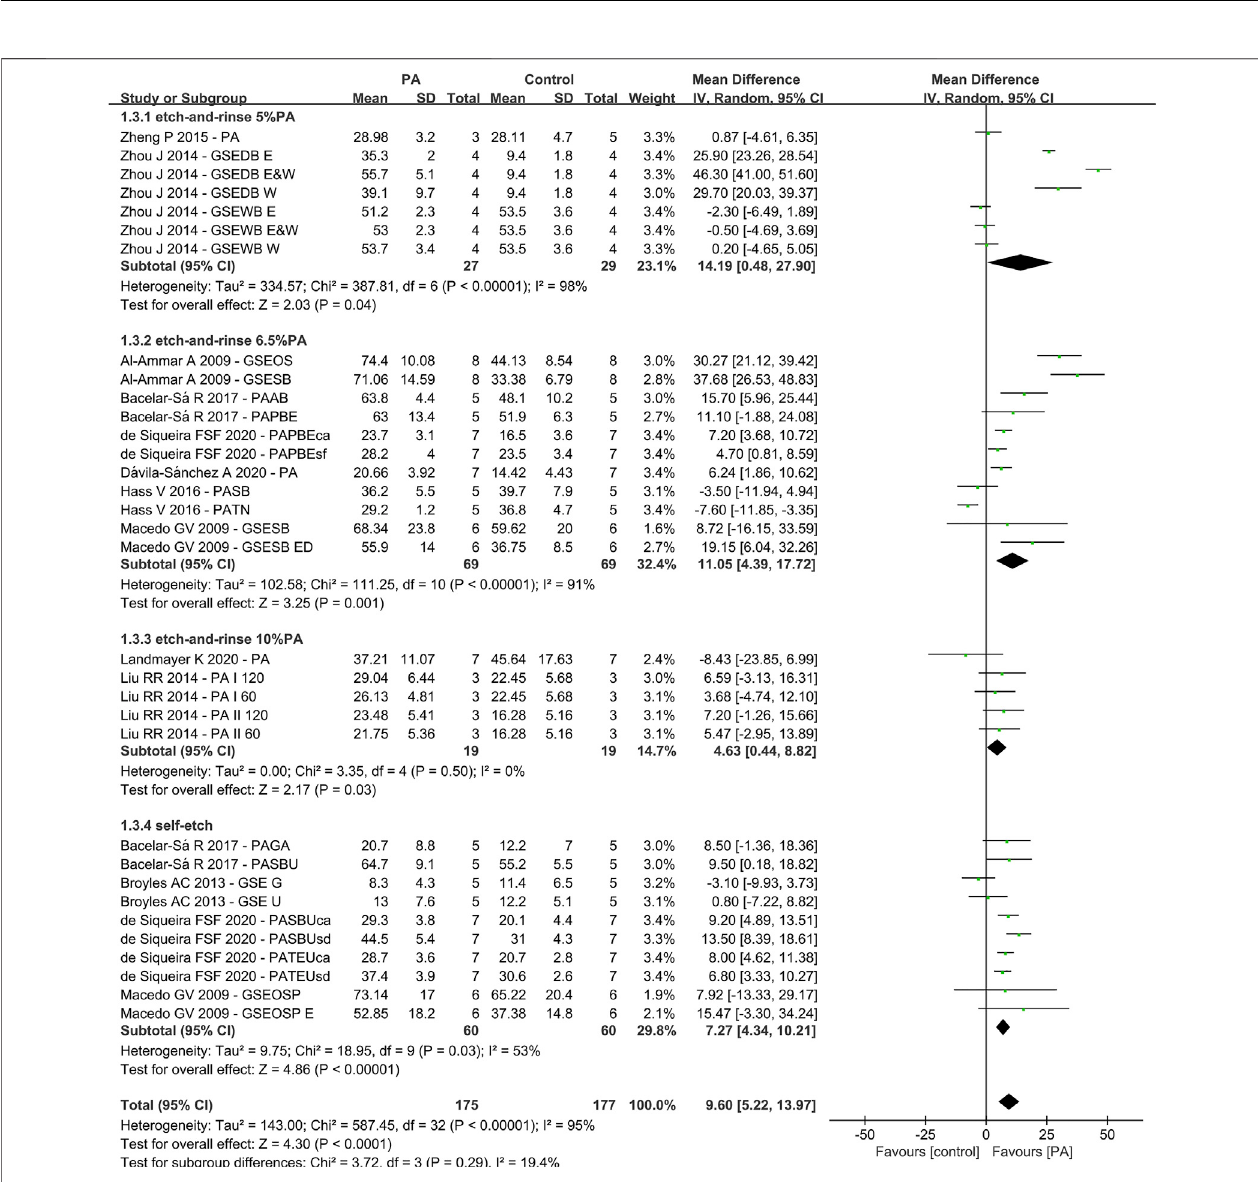
FIGURE 5 | Forest Plot — proanthocyanidin (PA) primers